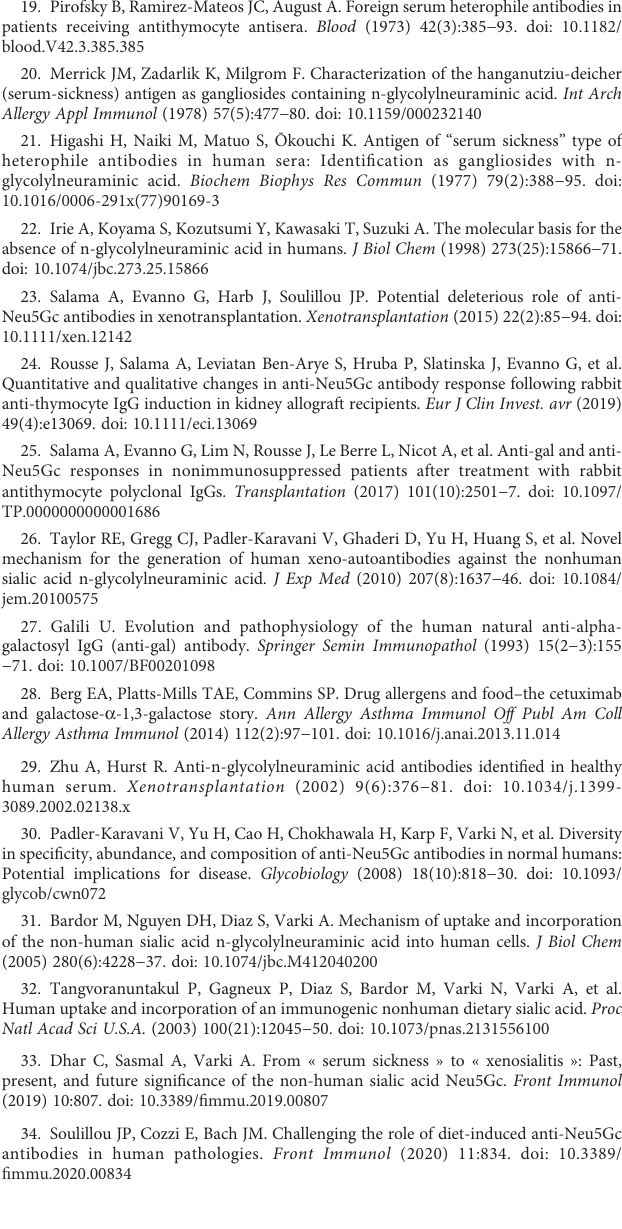
Supplemental Table 1 Overview of the in vivo analysis of cynomolgus monkeys. Cynomolgus monkeys (n=16) received I.V. daily doses ranging from 40 to 75 mg/kg GH-ALG for 5 days. The characteristics of these in vivo studies are described here. Supplemental Figure 1 Comparison of pig and rabbit IgG detection by G protein: (A) ELISA: GH-ALG and rabbit-ATG are coated on a maxisorp plate at